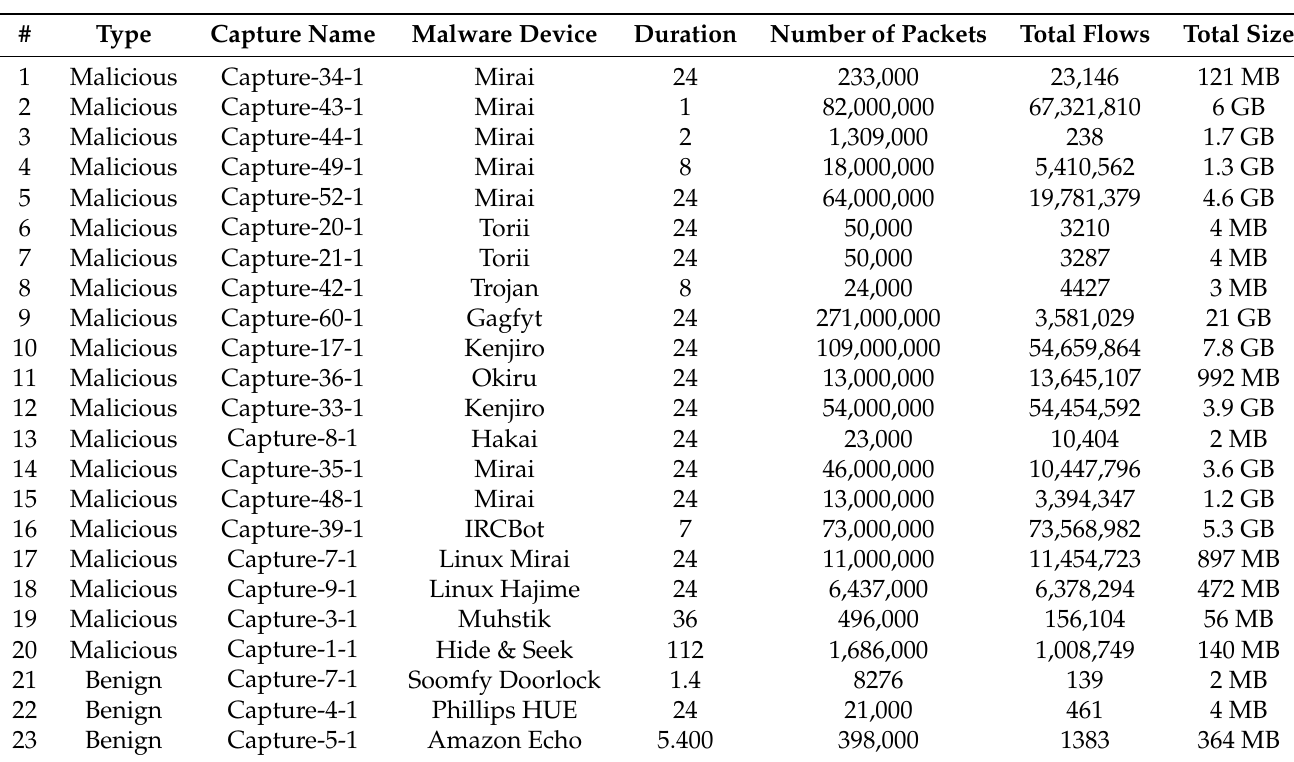
Table 2. IoT-23 dataset